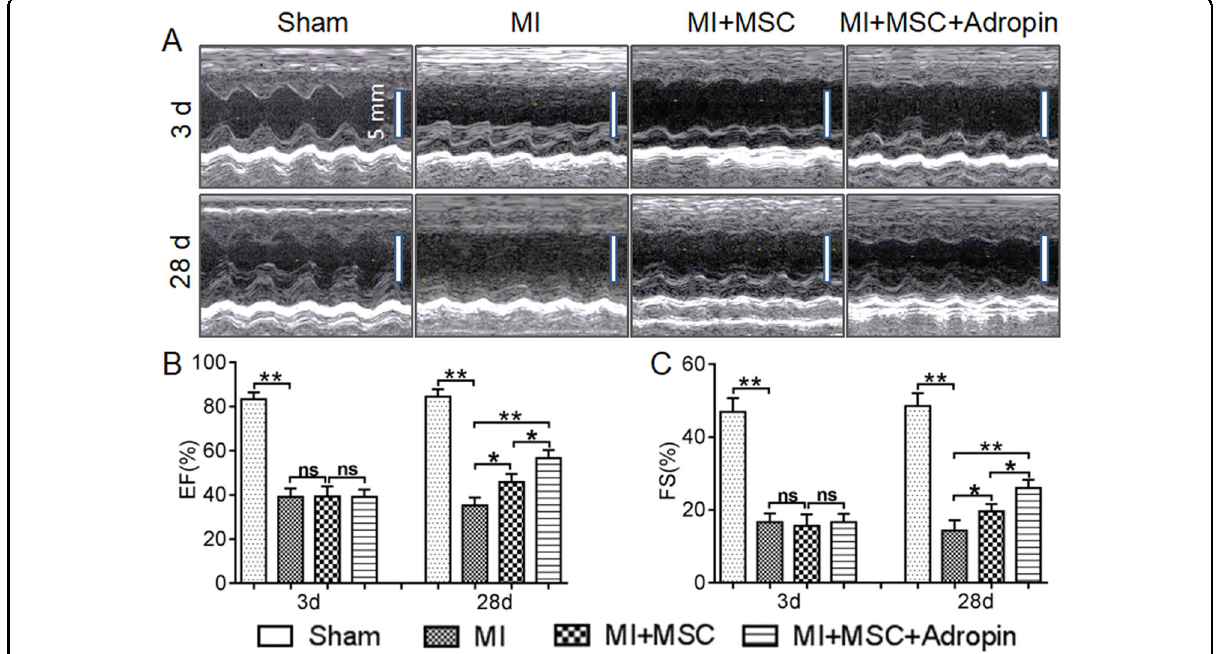
Fig. 2 Improved cardiac function by adropin-based dual treatment through modifying both transplanted MSCs and host MI microenvironment in rats. The adropin-treated MSCs (modi fi ed “ seed ” ) were implanted into the adropin-treated injured myocardium (modi fi ed “ soil ” ), thus implementing dual protective effects of adropin. Representative echocardiograms in M-mode from four groups were shown in ( A ). Left ventricular EF and FS were shown in ( B , C ), respectively. MSCs Mesenchymal stem cells. MI Myocardial infarction. EF Ejection fraction. FS Fractional shortening. Data are expressed as mean ± SD, n = 8. * p < 0.05; ** p < 0.01. NS No signi fi